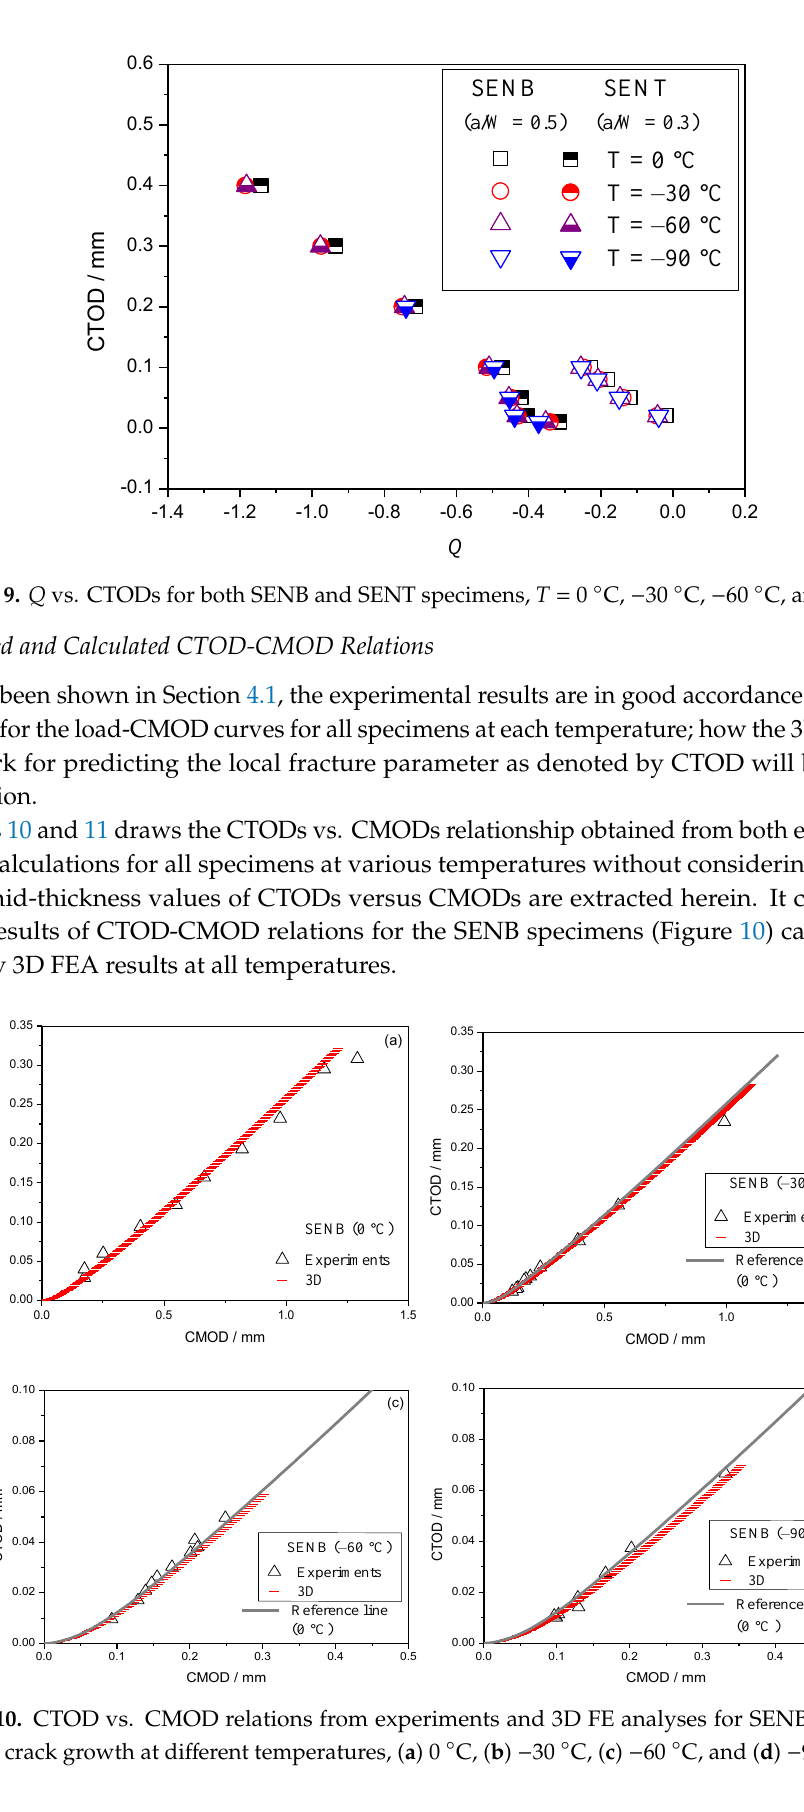
Figure 10. CTOD vs. CMOD relations from experiments and 3D FE analyses for SENB specimens without crack growth at different temperatures, ( a ) 0 °C, ( b ) −30 °C, ( c ) −60 °C, and ( d ) −90 °C [25].